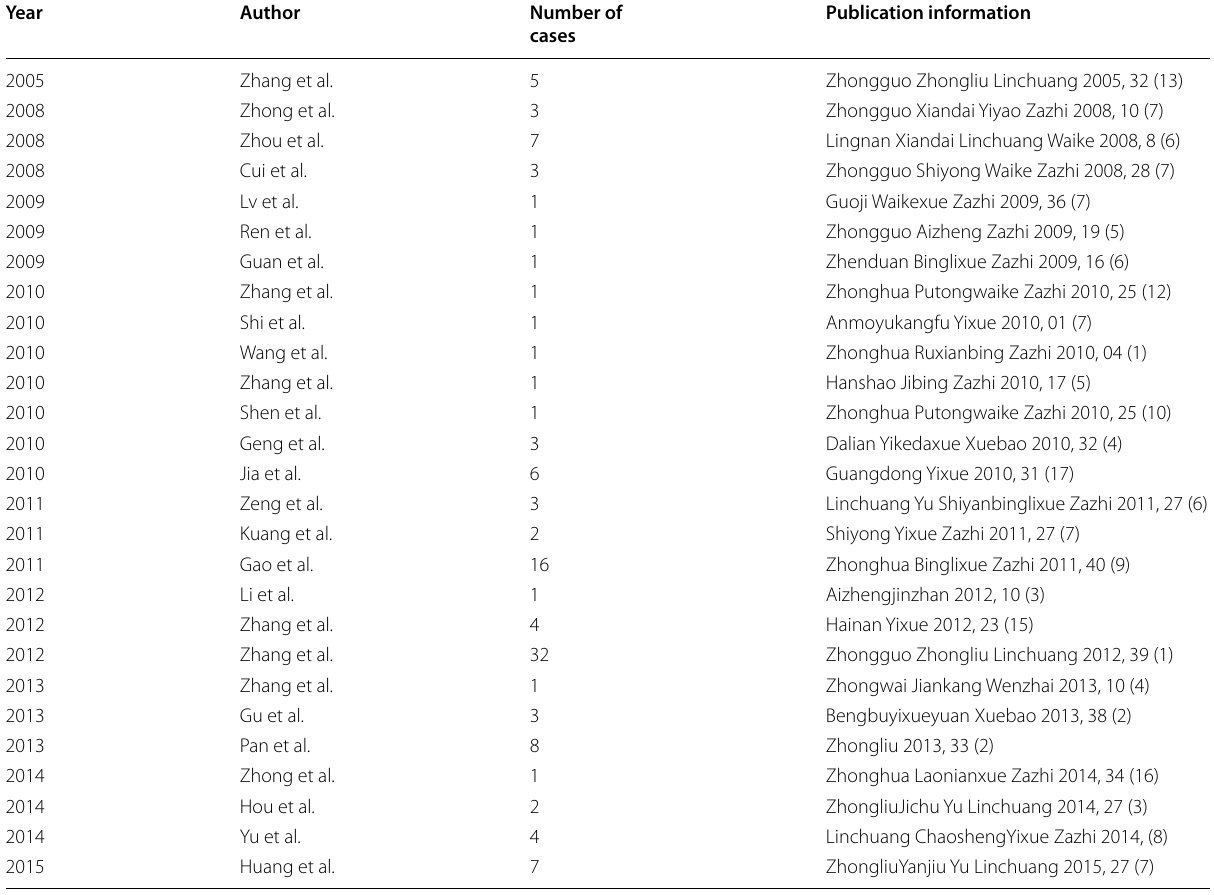
NECB neuroendocrine carcinoma of the breast